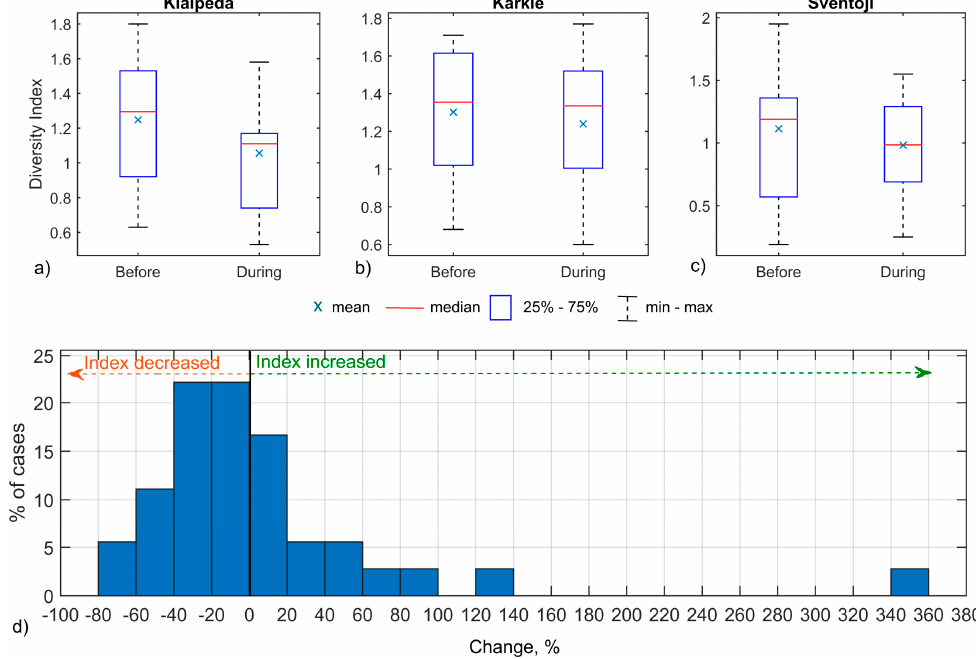
Figure 7. The minimum, maximum, mean, and median values of the Diversity index in all three study sites. Boxplots indicate 25–75% percentiles ( a − c ). Percentage change of Diversity index during upwelling event ( d ).